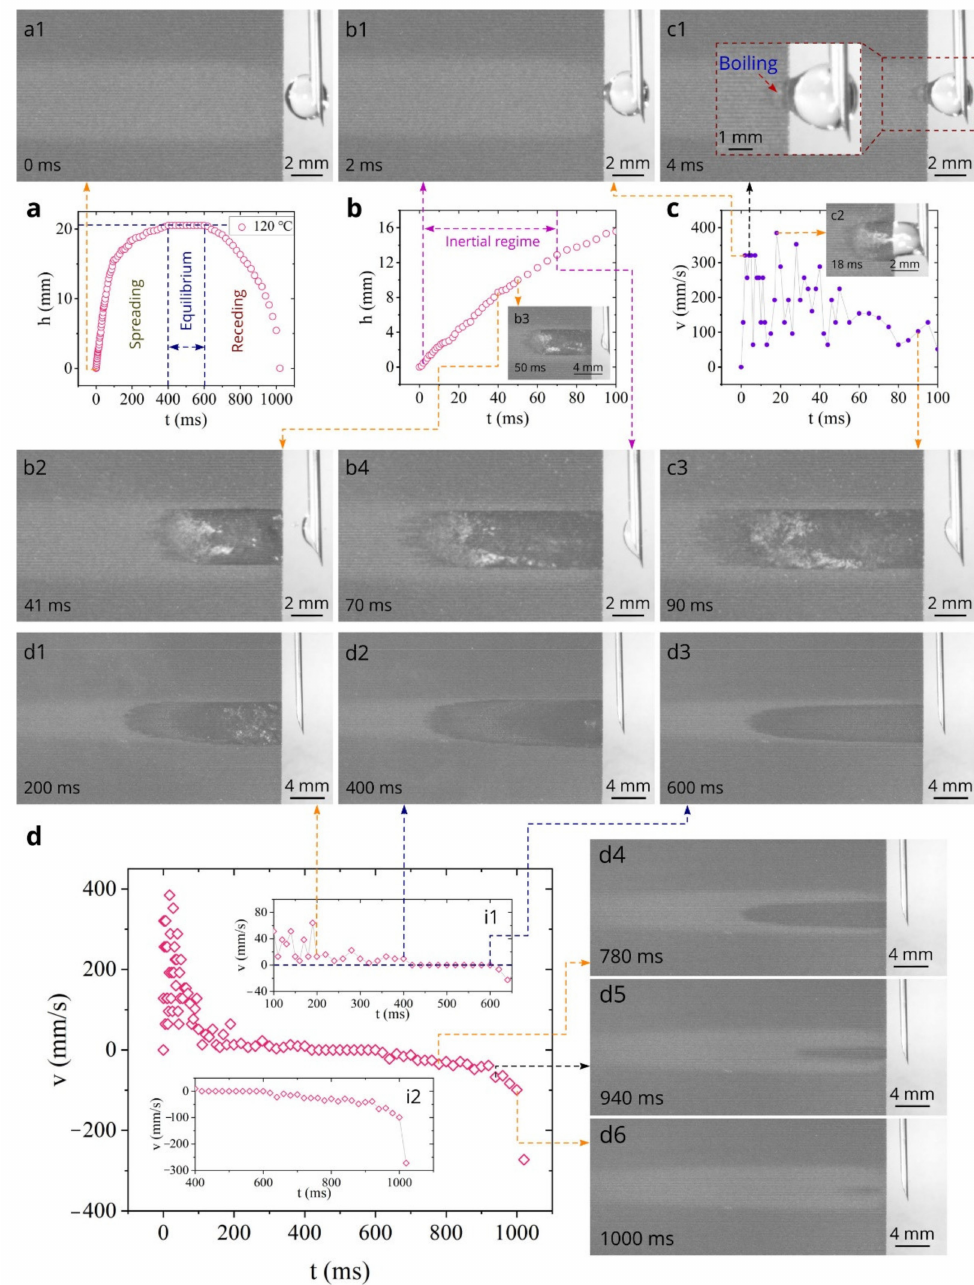
Figure 6. The h ( t ) and v ( t ) dependencies at 120 ◦ C and snapshots of water behaviors in spreading, equilibrium, and receding regimes for sample #1. ( a ) The overall plot of the spreading distance as a function of time (a1 is a snapshot of the sample surface and water drop at t = 0). ( b ) Detailed h ( t ) plot in the time domain between 0 and 100 ms (b1–b4 are snapshots of water spreading associated with h ( t ) dependence). ( c ) Detailed plot of the spreading velocity as a function of time between 0 and 100 ms (c1–c3 are snapshots of water spreading associated with v ( t ) dependence). ( d ) The overall plot of spreading and receding velocities as a function of time (d1–d6 are snapshots of water spreading associated with overall v ( t ) dependence. The insets i1 and i2 show detailed v ( t ) dependencies in the time domains of 100–650 and 400–1020 ms,